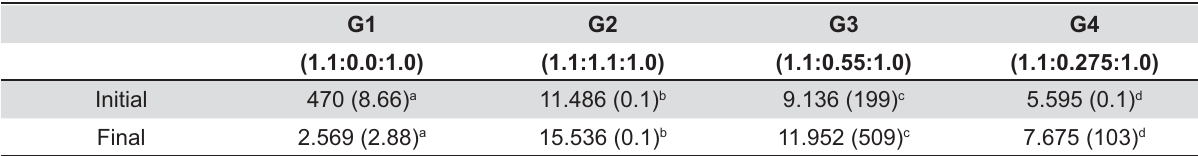
Table 1- (cid:2)(cid:30)(cid:6)(cid:12)(cid:8)(cid:2)(cid:12)(cid:8)(cid:15)(cid:2)(cid:11)(cid:9)(cid:12)(cid:8)(cid:15)(cid:12)(cid:7)(cid:15)(cid:2)(cid:15)(cid:6)(cid:31)(cid:4)(cid:12)(cid:9)(cid:4)(cid:27)(cid:8)(cid:2)(cid:27)(cid:5)(cid:2)(cid:9)(cid:14)(cid:6)(cid:2)(cid:4)(cid:8)(cid:4)(cid:9)(cid:4)(cid:12)(cid:10)(cid:2)(cid:12)(cid:8)(cid:15)(cid:2)(cid:17)(cid:8)(cid:12)(cid:10)(cid:2)(cid:11)(cid:6)(cid:9)(cid:9)(cid:4)(cid:8)(cid:16)(cid:2)(cid:9)(cid:4)!(cid:6)(cid:11)(cid:2)(cid:4)(cid:8)(cid:2)!(cid:4)(cid:8)(cid:29)(cid:9)(cid:6)(cid:11)(cid:2)(cid:5)(cid:27)(cid:7)(cid:2)"(cid:6)(cid:12)(cid:10)(cid:6)(cid:7)(cid:2)#$(cid:2)(cid:12)(cid:8)(cid:15)(cid:2)(cid:6)%(cid:26)(cid:6)(cid:7)(cid:4)!(cid:6)(cid:8)(cid:9)(cid:12)(cid:10)(cid:2) mixtures